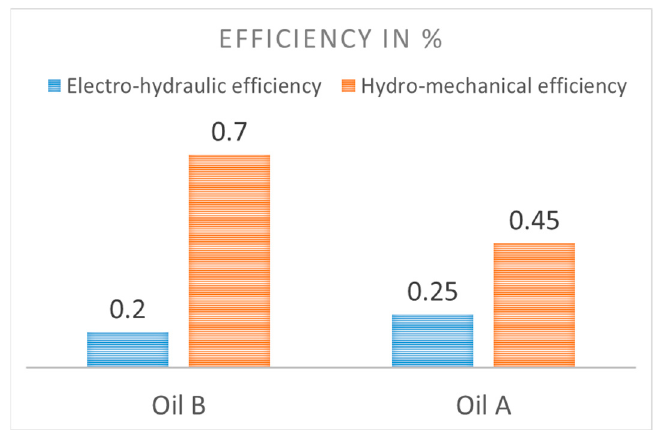
Figure 7. Electro-hydraulic efficiency and hydro-mechanical efficiency during lifting with a motor speed of 1000 rpm and zero payload with oils A and B at ambient temperature of +3 °C.